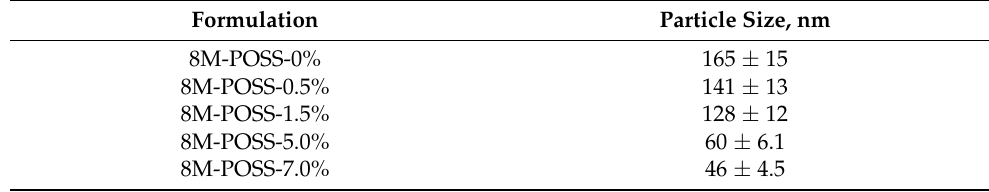
Table 2. The r ange of diameters (nm)of polymer particles formed in EMImNTf 2 + PC mixture.